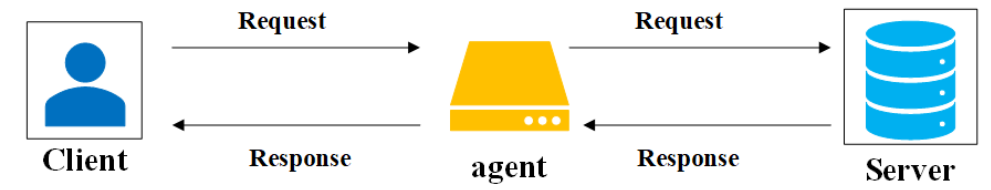
Figure 3. Fiddler working schematic.